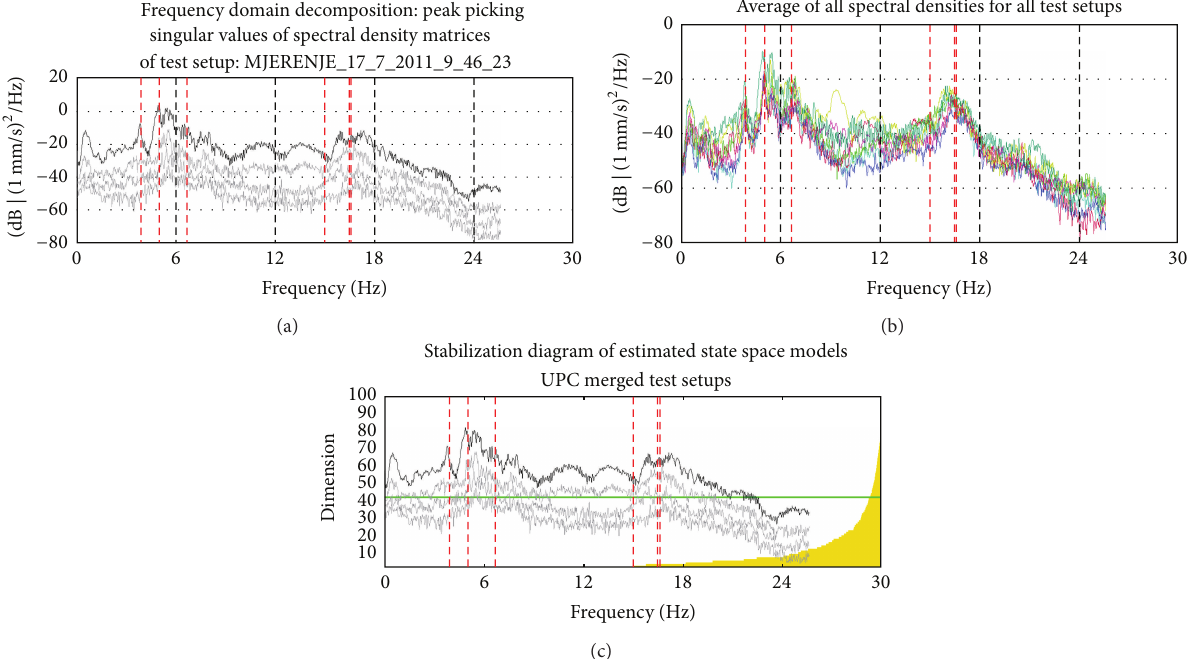
Figure 11: Dynamic characteristics attained from the test using EFDD and SSI methods: (a) singular values of spectral density matrices, (b) average of auto spectral densities, and (c) stabilization diagram of estimated state space model.